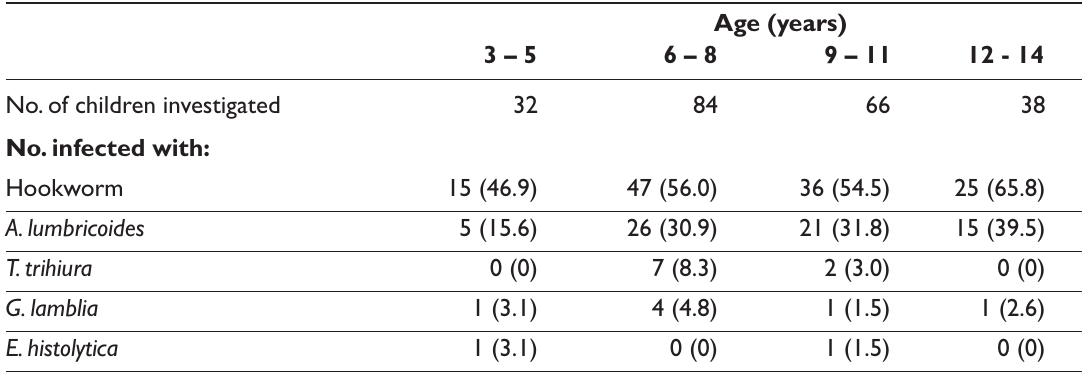
Table 2. The Age-Specific Prevalence of Intestinal Parasite among 220 Rural